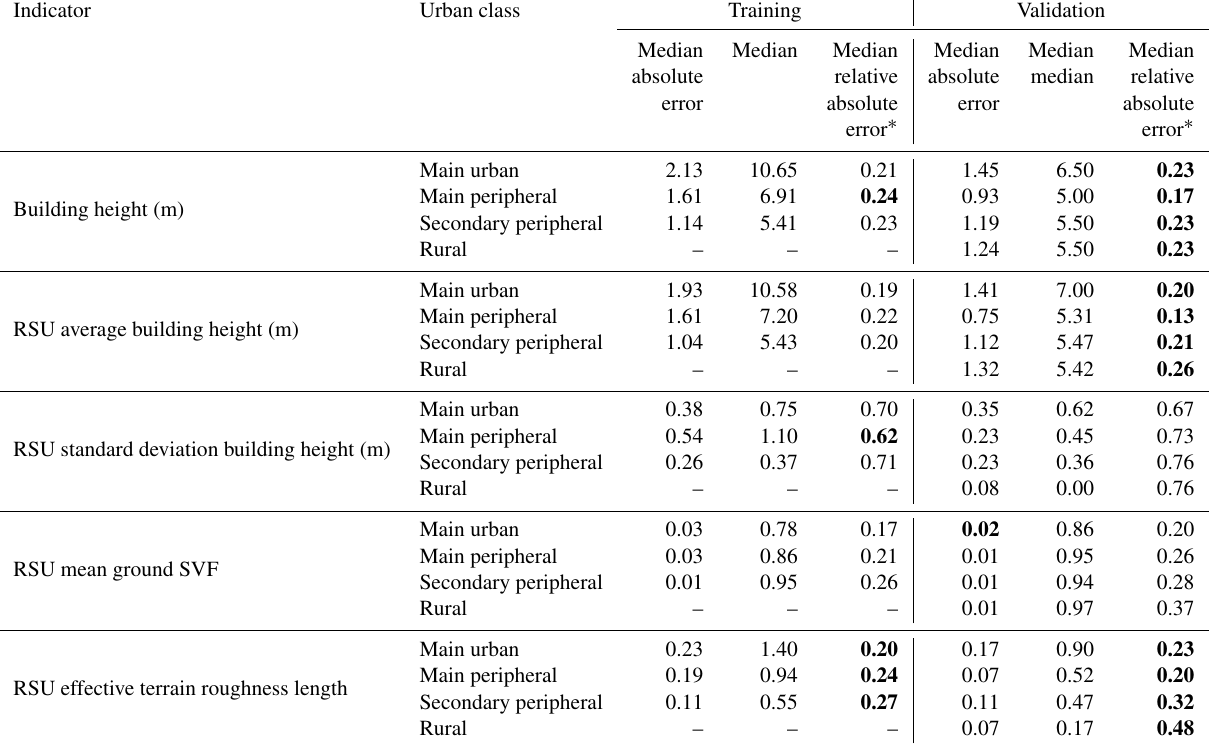
Table 5. Summary of the main statistics for each combination of {indicator, commune type, dataset type}. Bold values are the ones described in the